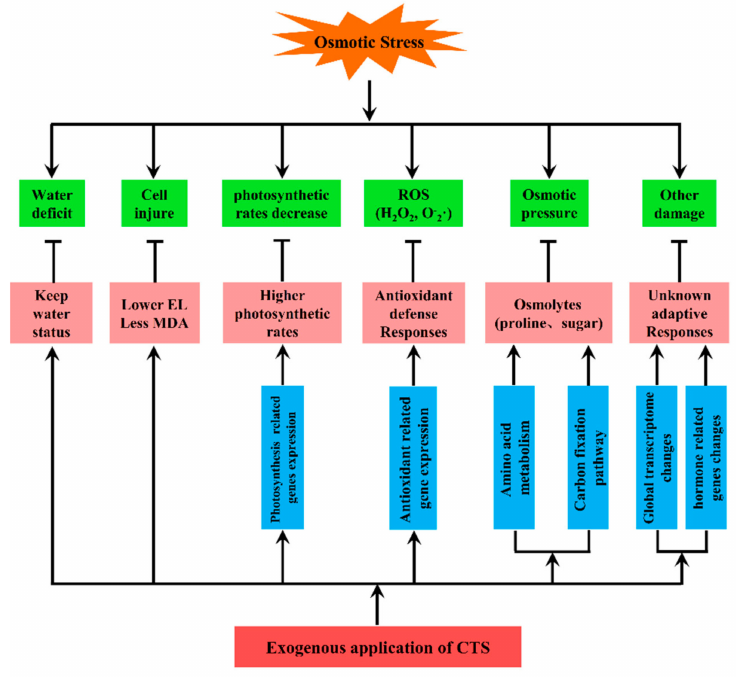
Figure 9. A proposed model for CTS-mediated osmotic stress responses in annual ryegrass.